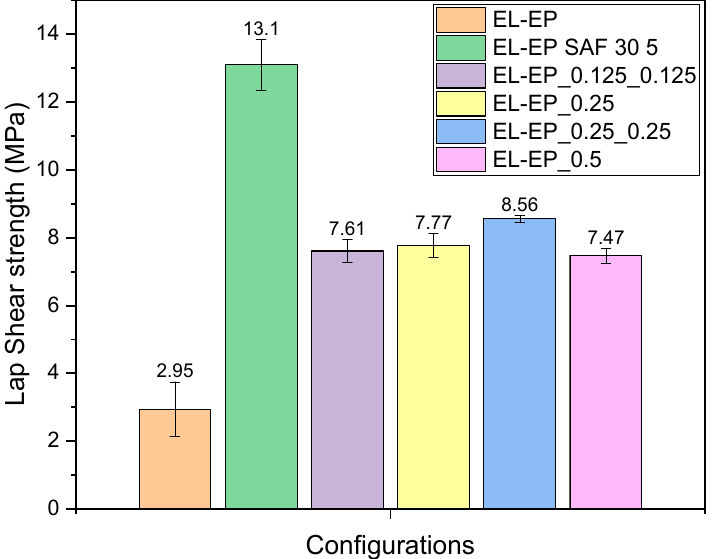
Figure 15. Maximum Lap shear strength comparison for each bonded configuration. There was no significant change in LSS when comparing EL-EP_0.25 and EL- EP_0.25_0.25. This indicated that the penultimate layer had little to no effect on the bond- ing strength, as confirmed from the SEM images of the interface of these two configura- tions, which showed that the penultimate layer was unaffected after welding, as will be discussed later. In comparison to EL-EP_0.25_0.25 with EL-EP-ED, where a different ED was used, EL-EP_0.25_0.25 showed a 13% lower LSS value. The results were expected, as using in- tegrated/semi-circular ED proved to form better bonds than flat ED, based on the compar- ison performed by S.K. Bhudolia et al. [51]. However, integrated/semi-circular EDs do pose some difficulties in terms of the welding of complex geometries and proper control of injection parameters to form an ED without air bubbles during manufacturing[51]. Even though the LSS obtained using a flat ED was slightly lower, it was still useful in welding complex geometries such as tubular cross-sections. Comparing ultrasonic welded and adhesive joints, EL-EP_0.25_0.25 showed an LSS value 35% lower than that from EL-EP SAF 30 5. Even though ultrasonically welded joints in this configuration are weaker in strength, there are other factors, such as manpower and time, where they are comparatively better than an adhesive joint. An adhesive joint requires time and effort for proper surface preparation before the application of adhesive. The welding time required is only 2 s as compared to 10 min for the adhesive to cure, and welding can significantly save the time required for bonding. Table 3. Maximum LSS of different weld configurations. Type of Weld